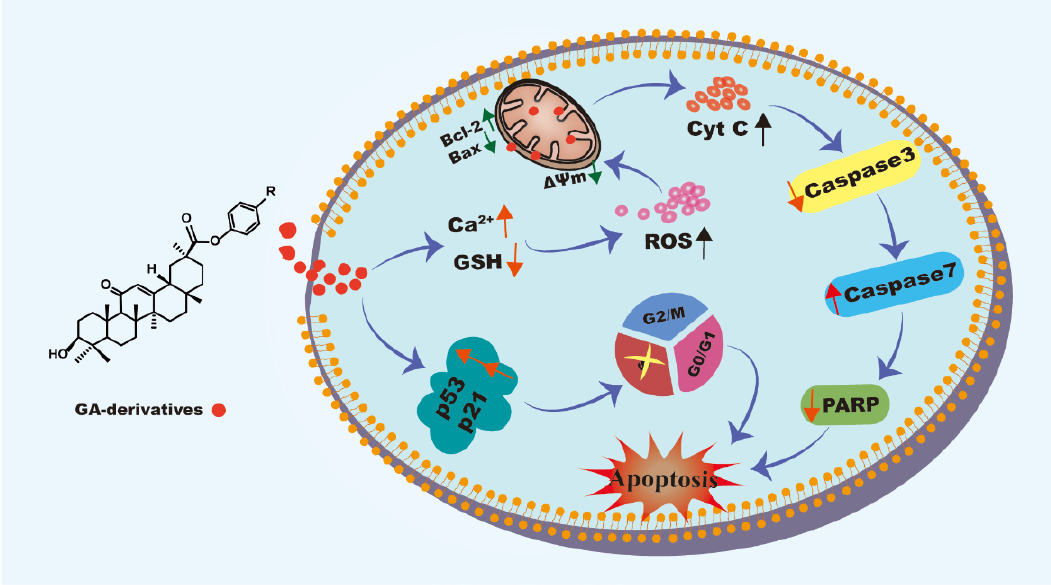
Figure 11. The mechanism of compound 3a inducing cell apoptosis. Supplementary Materials: The following supporting information can be downloaded at: https://www.mdpi.com/article/10.3390/molecules28073164/s1, Compound 3a : Figure S1 for 1 H NMR, Figure S2 for 13 C NMR, Figure S3 for HRMS; Compound 3b : Figure S4 for 1 H NMR, Figure S5 for 13 C NMR, Figure S6 for HRMS spectra, Compound 3c : Figure S7 for 1 H NMR, Figure S8 for 13 C NMR, Figure S9 for HRMS; Compound 3d : Figure S10 for 1 H NMR, Figure S11 for 13 C NMR, Figure S12 for HRMS spectra, Compound 3e : Figure S13 for 1 H NMR, Figure S14 for 13 C NMR, Figure S15 for HRMS; Compound 3f : Figure S16 for 1 H NMR, Figure S17 for 13 C NMR, Figure S18 for HRMS spectra, Figure S19 Determination of the purity of 3a using HPLC.